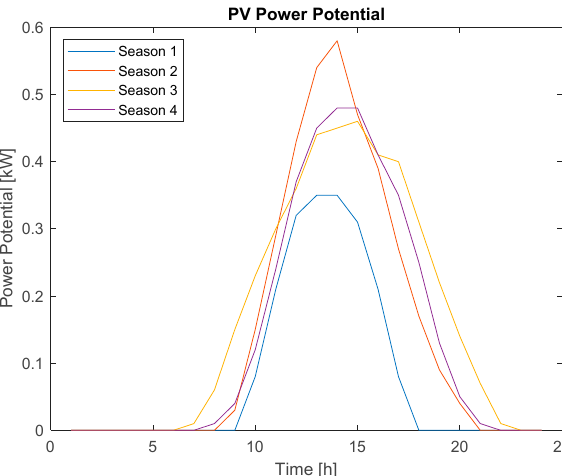
Figure 2. The estimated PV power potential for Toronto, Canada, shown for one day for each season, determined from data gathered from every individual day in each season [46,47].